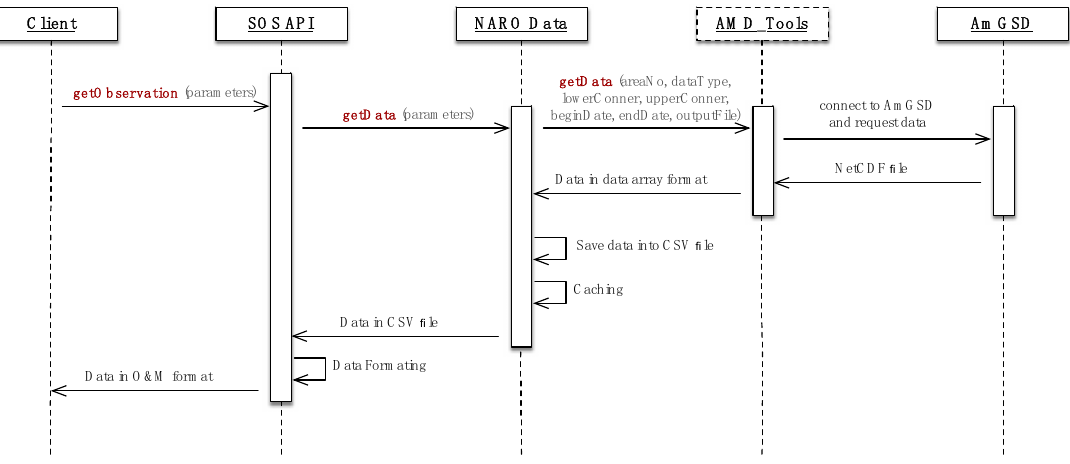
Figure 3. Sequence diagram of retrieving data. O&M, Observation and Measurements.